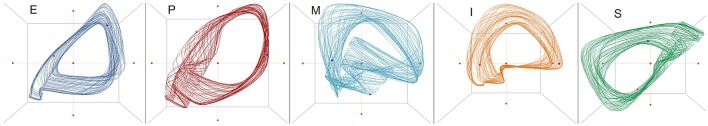
The attractors of the variables E, P, M, I, S in a chaotic regime with parameters and initial conditions as in Figure 3: a: 0.400, c: 0.675, r: 0.740, m: 0.475; E: 0.99, P: 0.57, M: −0.34, I: 0.01, S: −0.32. Three-dimensional time delay embedding with τ = 1. The attractors are based on 413 valid iterations (the last iterations from a simulation run of 5,000 iterations) splined by the Excel standard spline function.